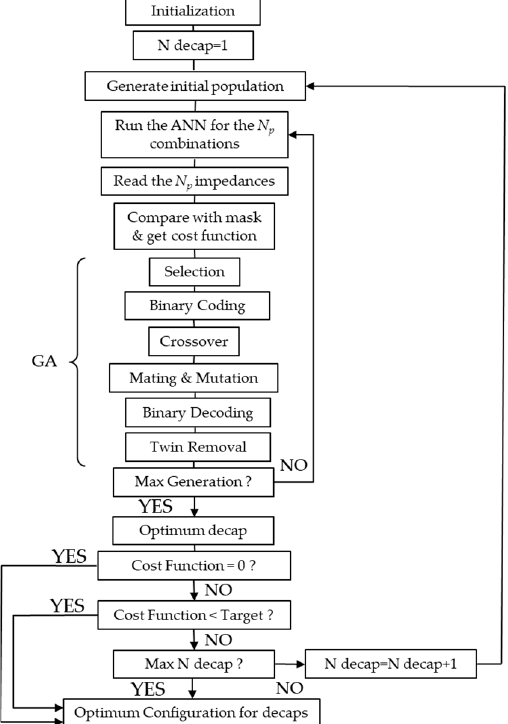
Figure 9. Flow chart of the iterative genetic algorithm (GA) optimization based on the ANN impedance calculation.